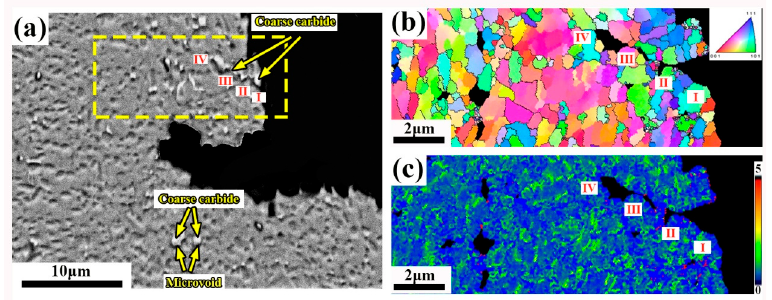
Figure 12. ( a ) SEM image of the typical tensile crack in the 0° sample; ( b , c ) IPF and KAM images of the secondary crack marked by the yellow box in ( a